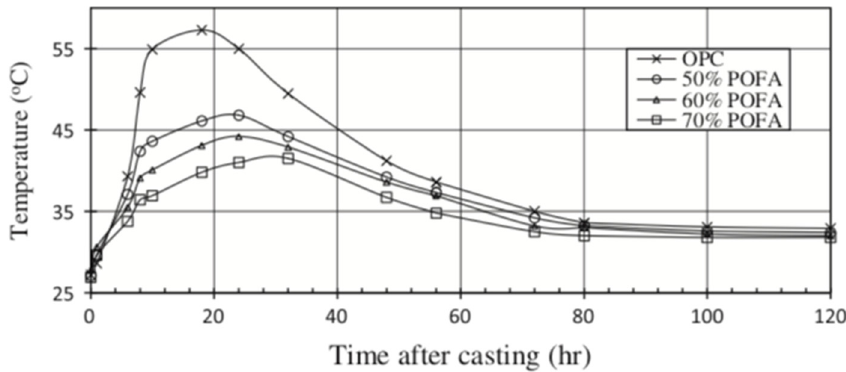
Figure 6. Temperature development in Portland cement concrete (OPC) and high-volume palm oil fuel ash (POFA) concrete [64].